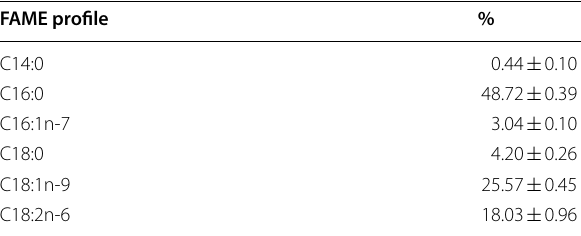
Table 2 Fatty acid profile of A. platensis biomass obtained in raceway